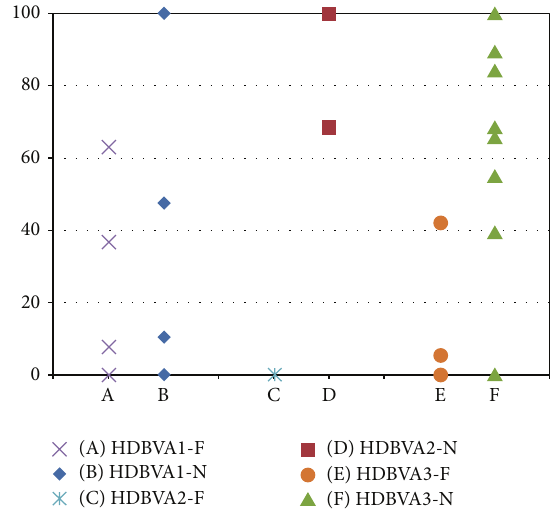
Figure 11: In-range slider displacement percentages of case Figure 10(a).